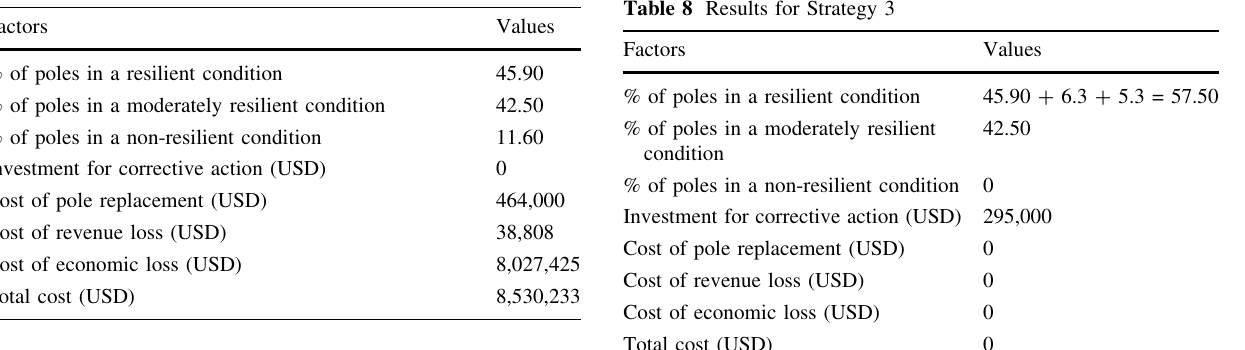
Table 6 Results for Strategy 1